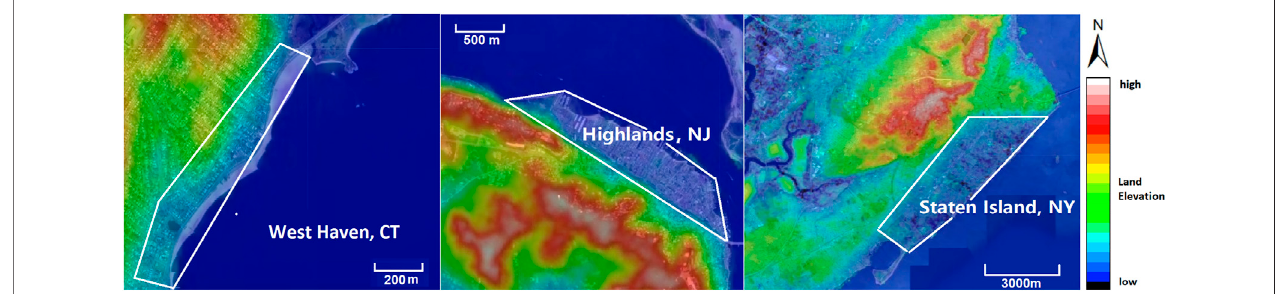
FIGURE1| Digital ElevationModel oflow-lyingCLaNs inHighlands, New Jersey;WestHaven,ConnecticutandStaten Island, New York(imagesfrom